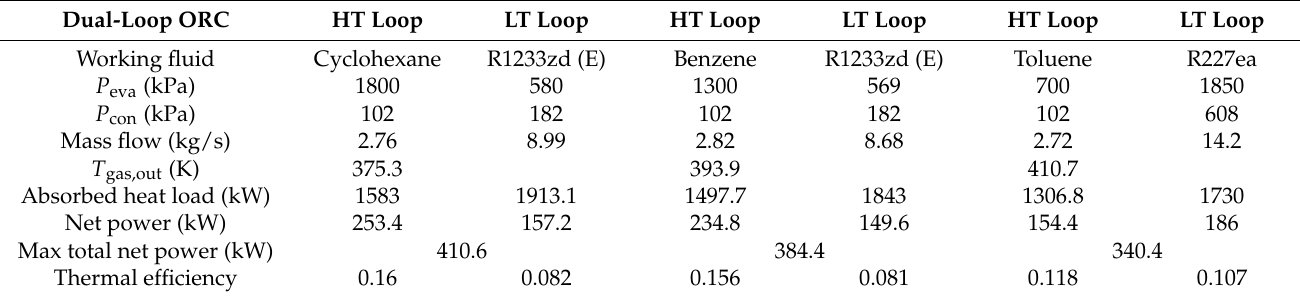
Table 3. The optimal numerical setup for a dual-loop ORC.